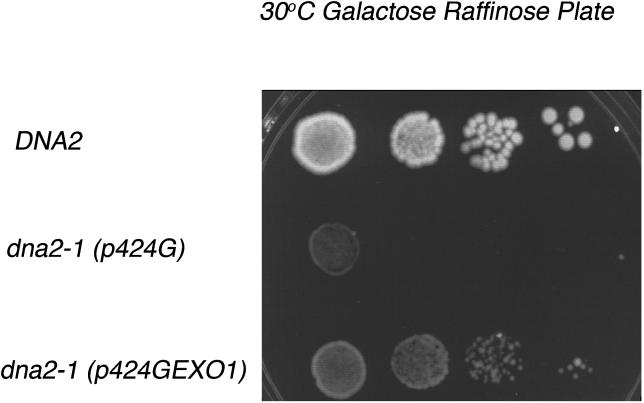
Suppression of dna2 by ExoIp OverexpressionStrain W303 dna2–1 was transformed with the plasmids pRS424G and pRS424G-EXO1, an empty plasmid vector and a plasmid expressing ExoIp from the GAL110 promoter, respectively. W303RAD5 strains dna2–1 7A(pRS424G) and dna2–1(pRS424G-EXO1) were grown to mid log phase and serially diluted on yeast-dextrose galactose- and raffinose-containing plates and incubated at 30 °C for 5 d.